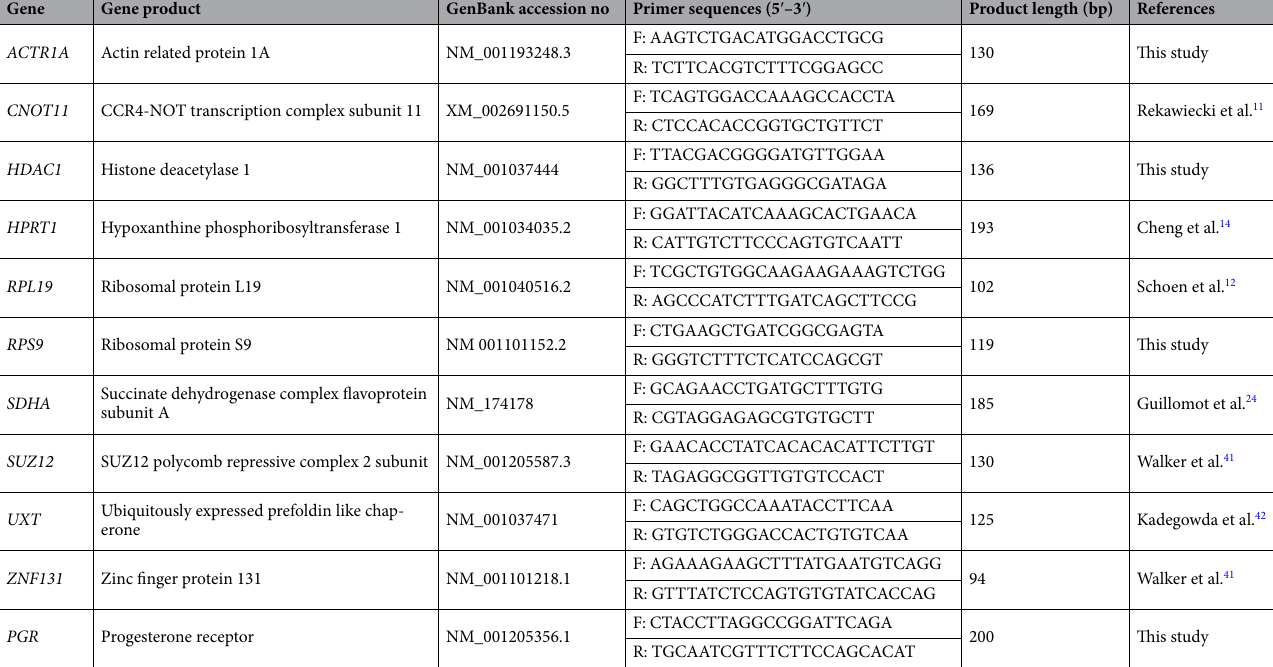
Table 2. Primer details of selected candidate reference genes and target